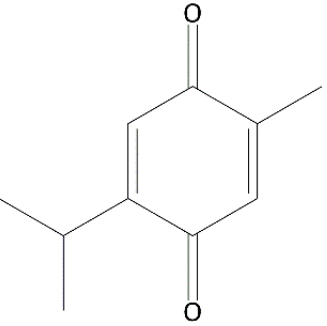
Figure 1. Thymoquinone Structure.